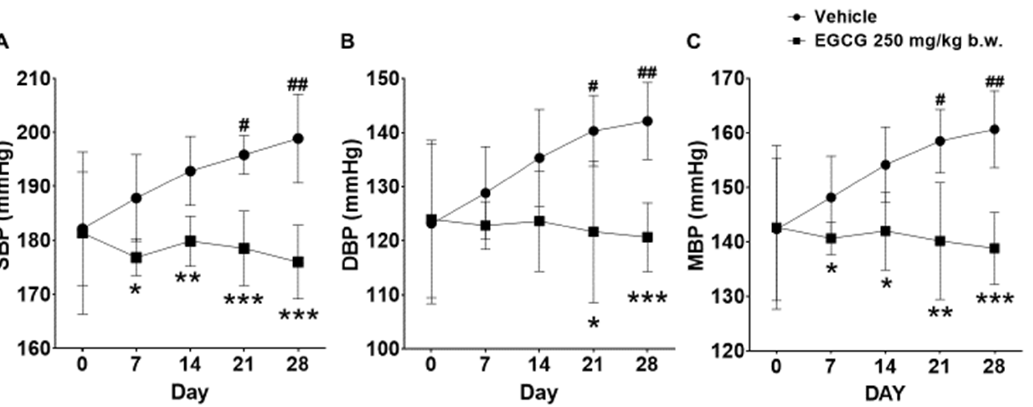
Figure 2. Effect of 28 days EGCG treatment on the ( A ) SBP, ( B ) DBP, and ( C ) MBP of the SHR. Data were expressed as mean ± SD, n = 6. # p < 0.05, ## p < 0.01 vs. day 0; * p < 0.05, ** p < 0.01, *** p < 0.001 vs. vehicle, two-way ANOVA followed by Dunnett’s test. SBP: systolic blood pressure, DBP: diastolic blood pressure, MBP: mean blood pressure.